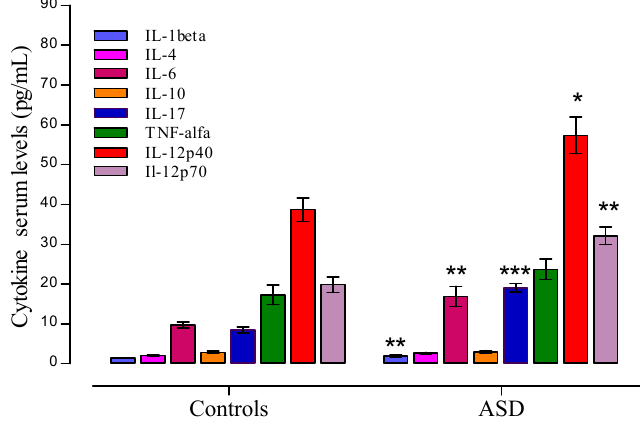
Figure 3. Plasma cytokine levels in Autism spectrum disorders (ASD) patients and controls. Significant data are showed as median ±SEM. Significant levels to * p < 0.05, ** p < 0.01, and *** p < 0.001, t Student test.